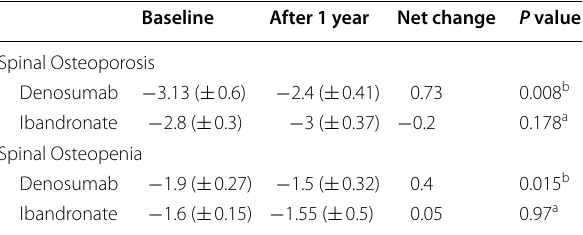
Table 3 Spinal T‑scores at baseline and after one year of